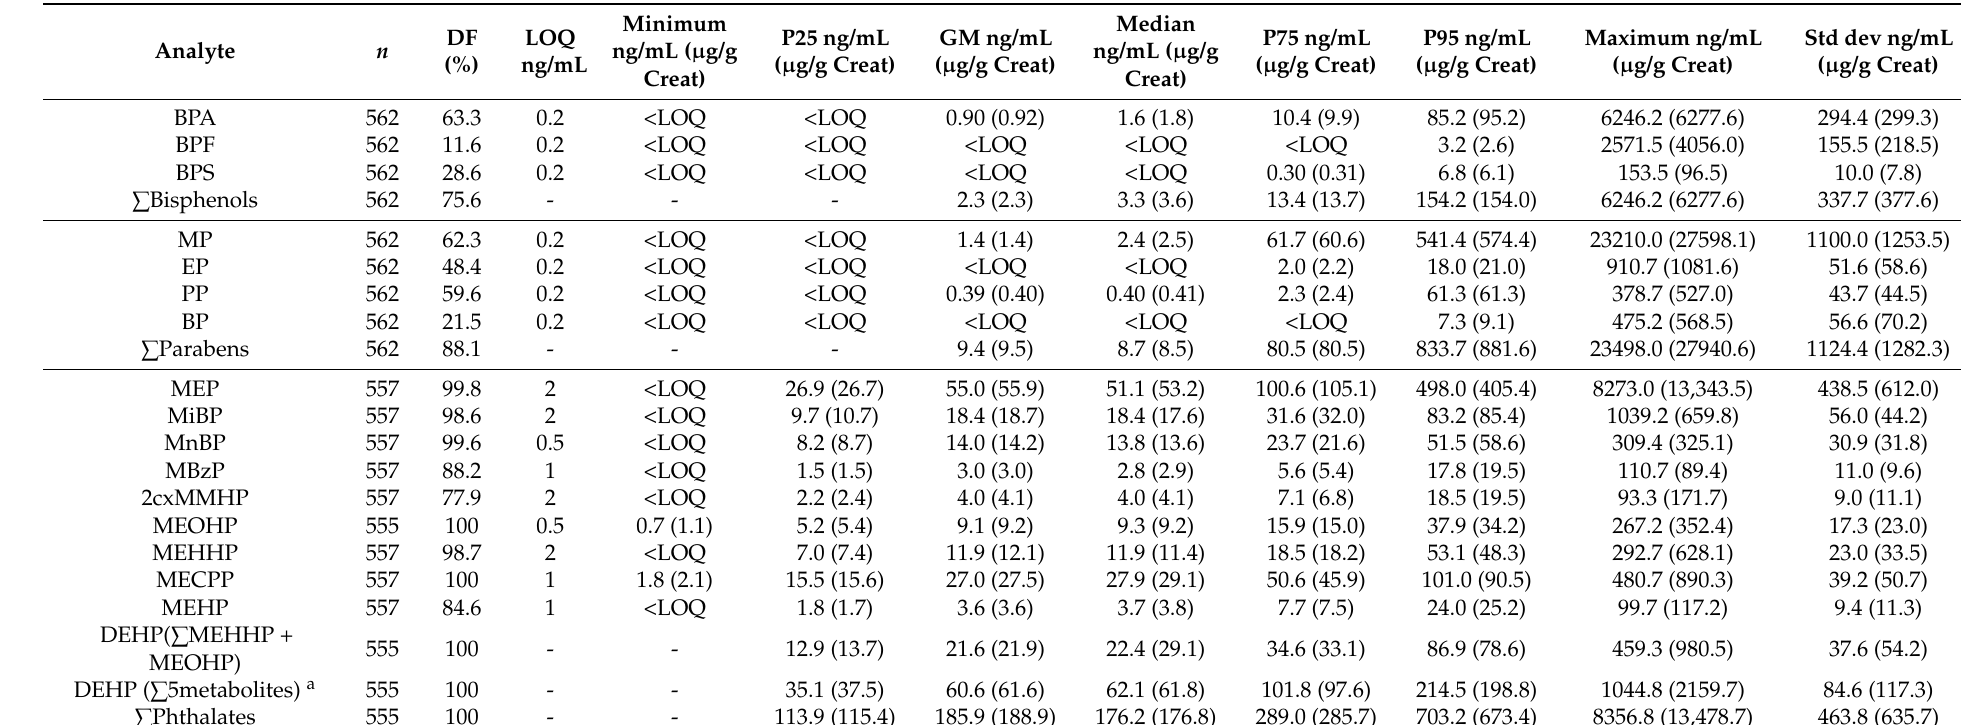
Table 2. Levels of contaminant biomarkers in urine